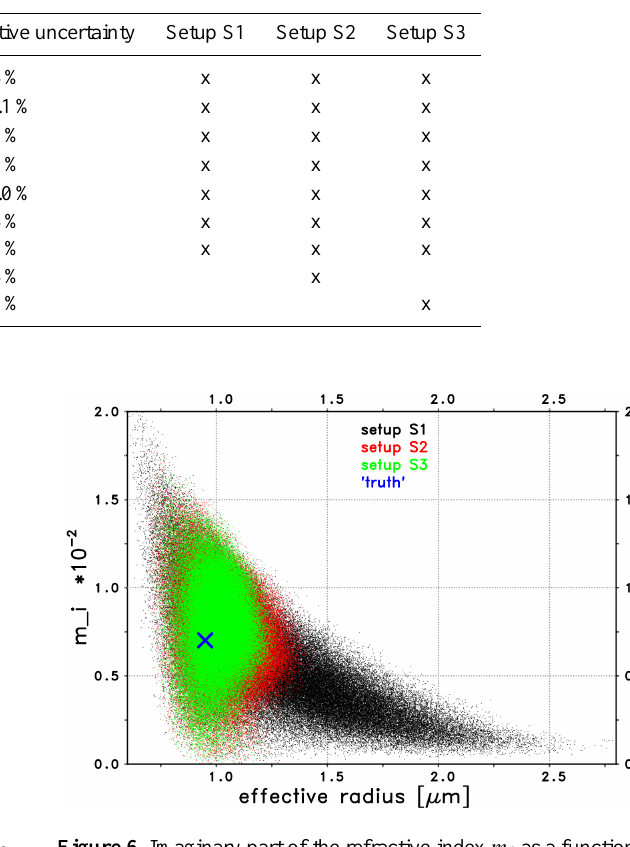
Figure 6. Imaginary part of the refractive index m i as a function of the effective radius, r eff , of the solution ensembles for the three lidar setups. The properties of the input ensemble (“truth”) are denoted with a blue